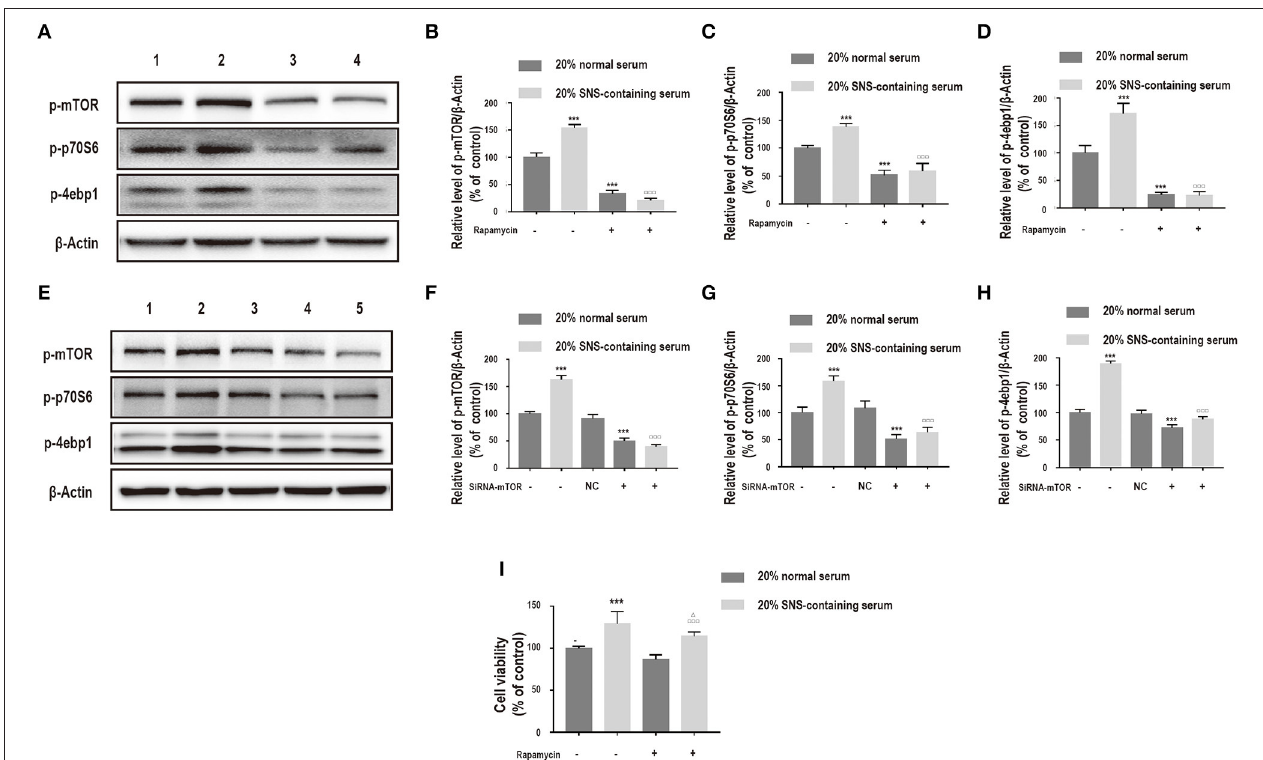
FIGURE 6 | (A–D) Cells were incubated with 200 µ M corticosterone, 1 µ M rapamycin, and 20% serum for 24h. Western blot and quantitative analyses of p-mTOR, p-p70S6, and p-4ebp1 expression. 1: 20% normal serum + corticosterone group; 2: 20% SNS-containing serum + corticosterone group; 3: 20% normal serum + corticosterone + rapamycin group; 4: 20% SNS-containing + corticosterone + rapamycin group. *** P < 0.01 vs. 20% normal serum + corticosterone group; (cid:3)(cid:3)(cid:3) P < 0.01 vs. 20% SNS-containing serum group ( n = 3). (E–H) siRNA-mTOR transfected cells were incubated with 200 µ M corticosterone and 20% SNS-containing serum for 24h. Western blot and quantitative analyses of p-mTOR, p-p70S6, and p-4ebp1 protein expression levels. 1: 20% normal serum + corticosterone group; 2: 20% SNS-containing serum + corticosterone group; 3: 20% normal serum + corticosterone + siRNA-NC group; 4: 20% normal serum + corticosterone + siRNA-mTOR group; 5: 20% + SNS-containing serum + siRNA-mTOR group ( n = 3). (I) CCK-8 assay for determination of cell viability. *** P < 0.01 vs. 20% normal serum group + corticosterone group; (cid:3)(cid:3)(cid:3) P < 0.01 vs. 20% normal serum + corticosterone + rapamycin; 1 P < 0.05 vs. 20% SNS-containing serum group + corticosterone group ( n =